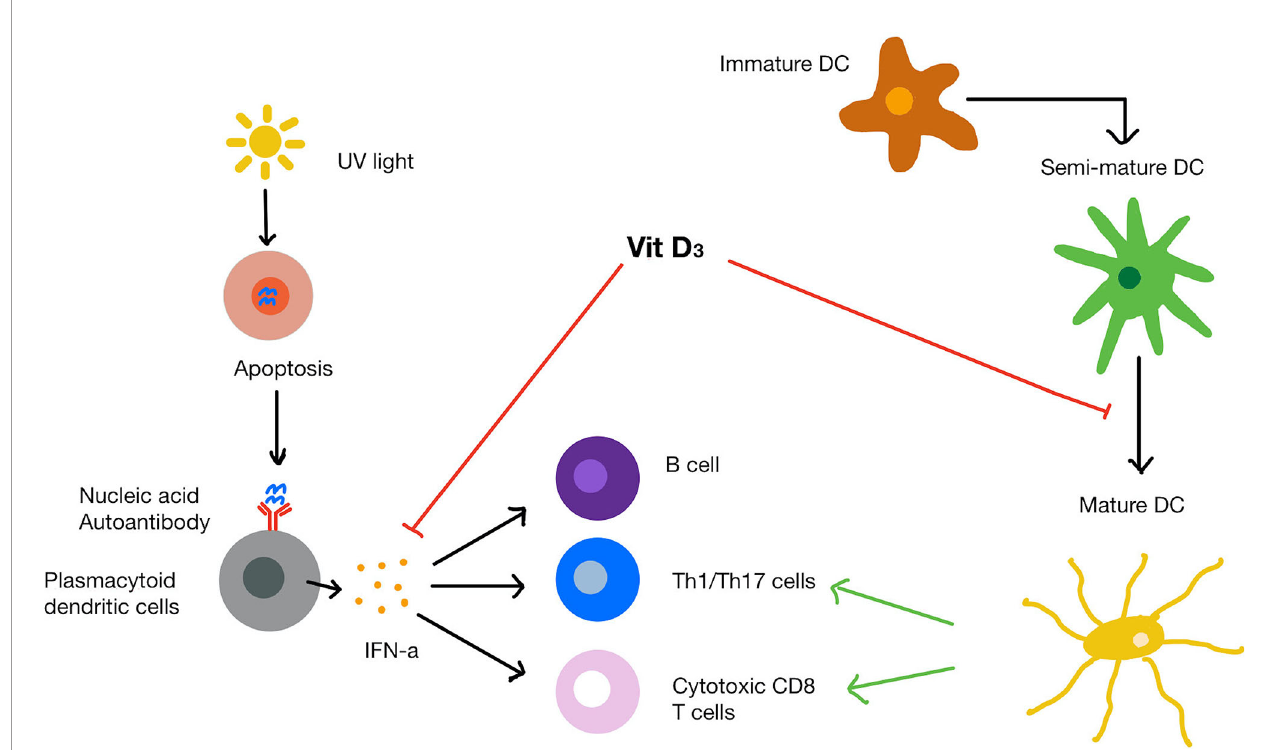
FIGURE 3 | SLE pathogenesis and mechanism of vitamin D on immune cells. UVB light causes apoptosis of cells that release endogenous nucleic acids. The nucleic acids bind to and trigger plasmacytoid dendritic cells to release IFN- a . Mature dendritic cells recruit T helper cells, cytotoxic T cells and B cells. Vitamin D increases protective innate immune response while dampening the over-active immune response. Vitamin D also inhibits the maturation of dendritic cells and suppresses IFN- a production from plasmacytoid dendritic cells as well as IFN- a induced gene